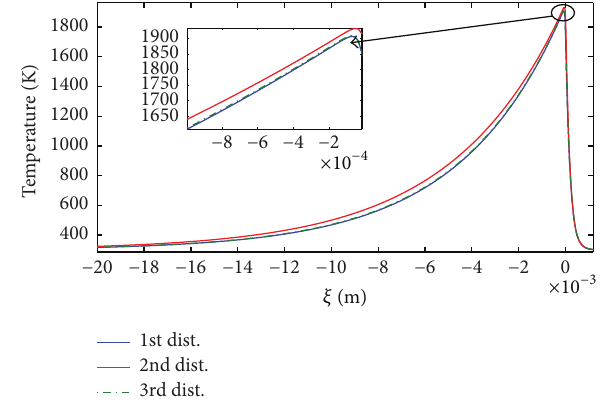
Figure 15: Effect of initial droplet size distribution on thermal profile in one-dimensional laminar spray flame propagation.